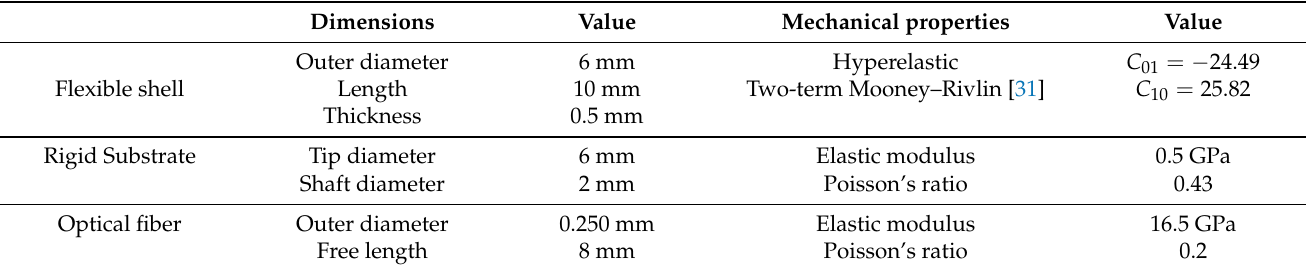
Table 1. Geometric dimensions and mechanical properties of the sensor used in the finite element study. Dimensions Value Mechanical properties Value 6 mm